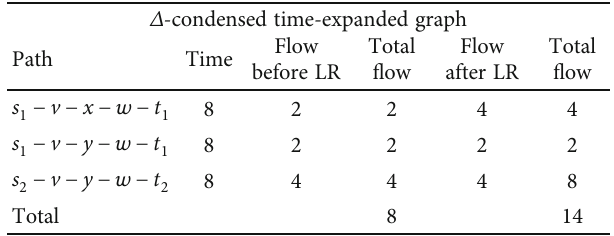
Total 14 LR=lane